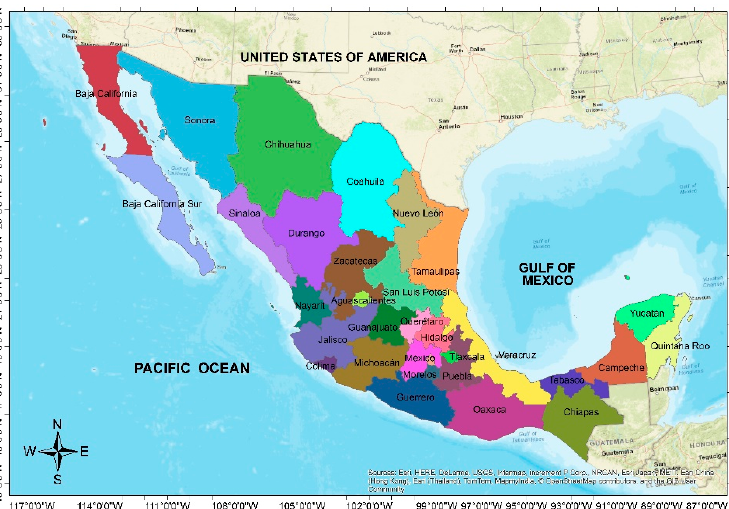
Figure 2. Geographical location and political distribution in the Mexican Republic.